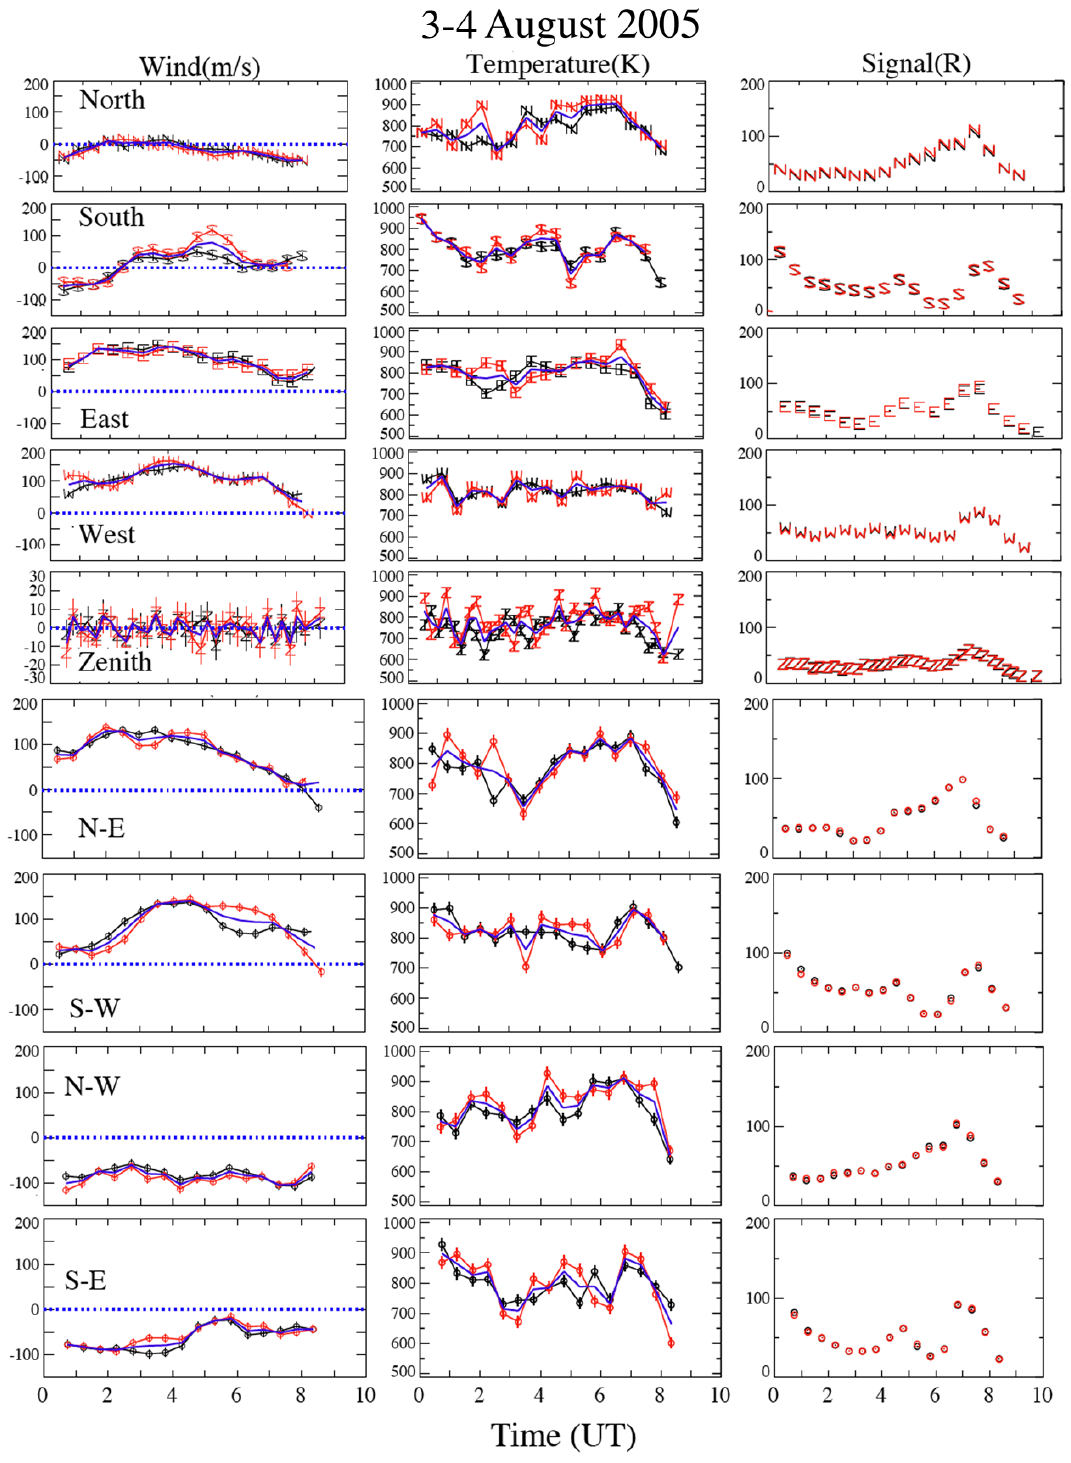
Fig. 4. Arequipa FPI measurements of horizontal wind components (left column), temperatures (middle column) and 630-nm intensities (right column) for 3–4 August 2005. The exposure time for each direction was 120s. The red, black, and blue lines in each panel are plots for the inner and outer orders observed in each image and the average of these results,